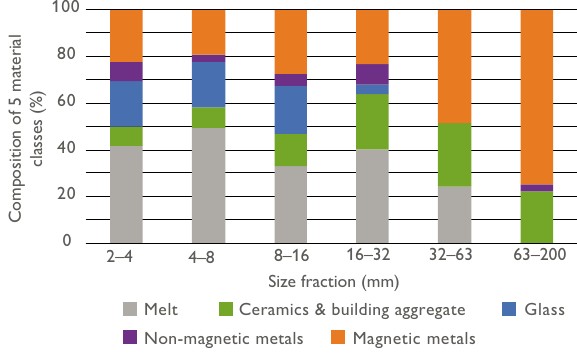
Fig. 3. The distribution of main components according to fragment size.